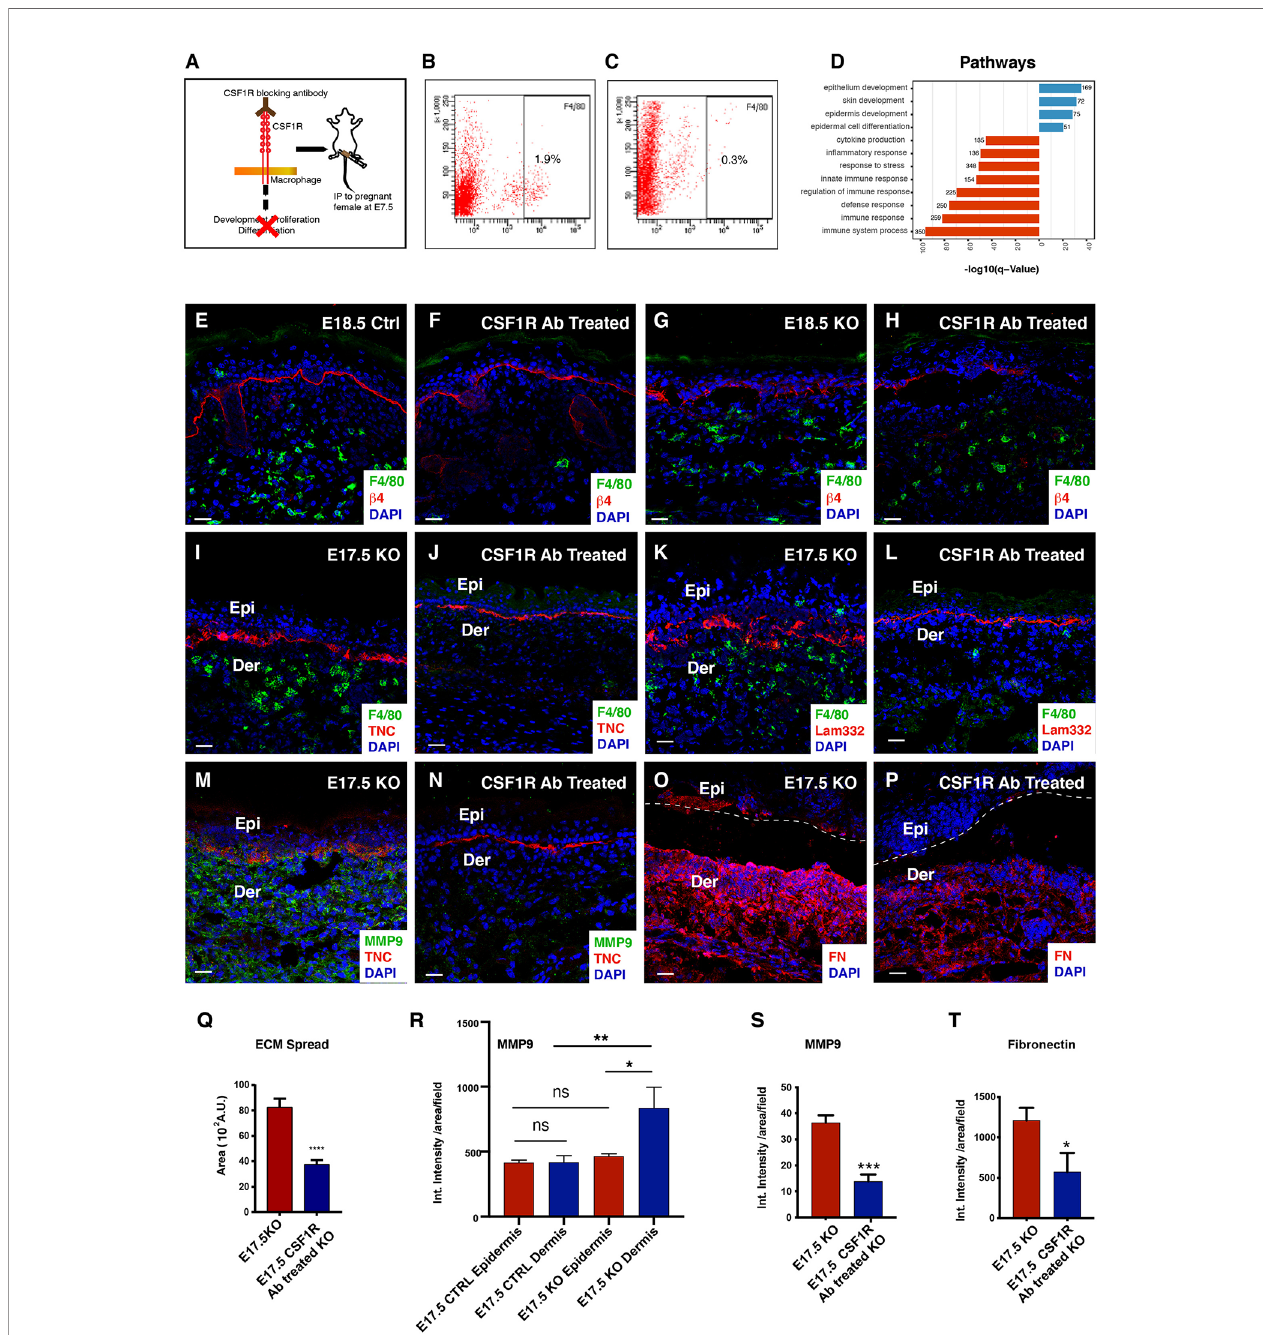
FIGURE 4 | Reduced BM disruption and ECM abundance in the macrophage depleted CSF1R blocked skin. Graphical illustration of the dosing strategy of CSF1R blocking antibodies to pregnant dams (A) . Flow cytometry analysis for F4/80 expression in the E17.5 Epidermal Itg b 1 KO PBS and CSF1R blocked skin, respectively (B, C) . Gene Ontology pathway analysis for the upregulated (blue) and downregulated (red) genes in the epidermis of the CSF1R blocked KO skin (D) . Immunostaining for F4/80 and Itg b 4 in the control, CSF1R antibody treated, untreated Itg b 1 KO, and CSF1R antibody treated epidermis Itg b 1 KO skin at E18.5 (E – H) . Immunostaining in the E17.5 PBS treated and CSF1R antibody treated KO skin for F4/80 and TNC (I, J) ; F4/80 and LAM332 (K, L) ; MMP 9 and TNC (M, N) and Fibronectin (O, P) (N=2). The white dashed line separates the epidermis (Epi) and dermis (Der). Scale bars: 20 µm. Quanti fi cation of the area of spread of the Lam332 staining in the E17.5 epidermal Itg b 1 KO PBS and CSF1R blocked skin (Q) (Control N=3, CSF1R blocked N=4; ****p ≤ 0.0001). Quanti fi cation of the staining intensity of MMP9 expression in the epidermis and the dermis of the PBS and the CSF1R antibody treated KO samples (R) (N=2; *p ≤ 0.05, **p ≤ 0.01, ns=not signi fi cant. Quanti fi cation of the staining intensity for MMP9 and fi bronectin (FN1) in the E17.5 epidermal Itg b 1 KO PBS and CSF1R blocked skin (S, T) (N=2; *p ≤